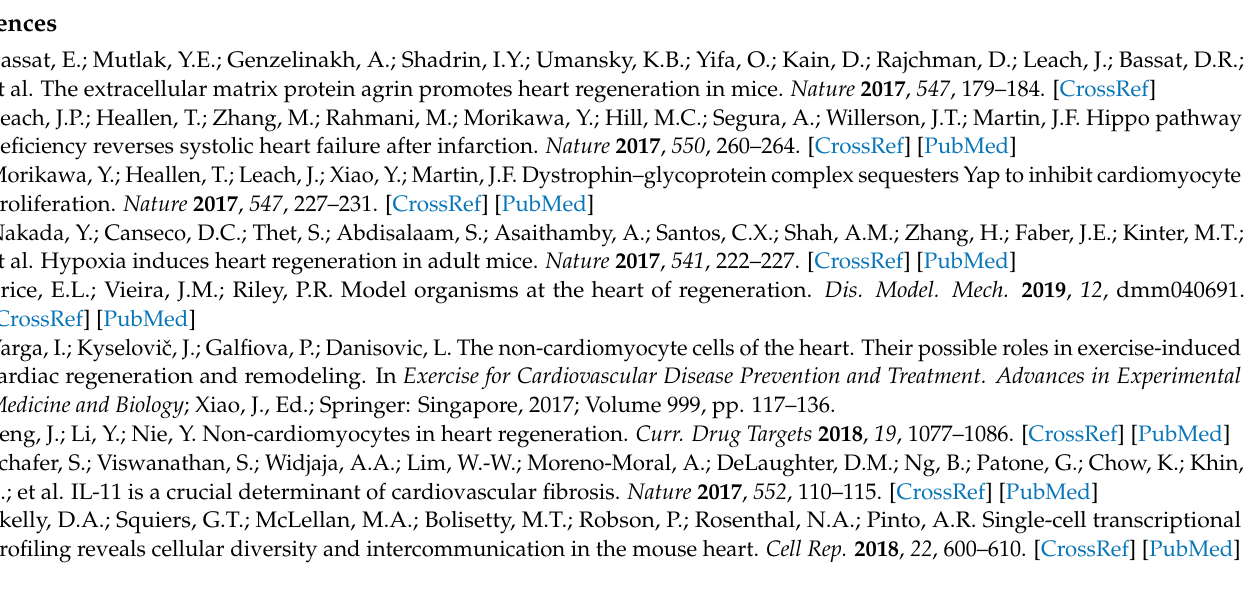
Figure S1: Violin plots showing the expression profiles of the feature genes of fibroblast subtypes, Supplementary Figure S2: Upset plots of homolog DEGs for three major cell types combined between Zebrafish-Ma-2021 and Mouse-Farbehi-2019